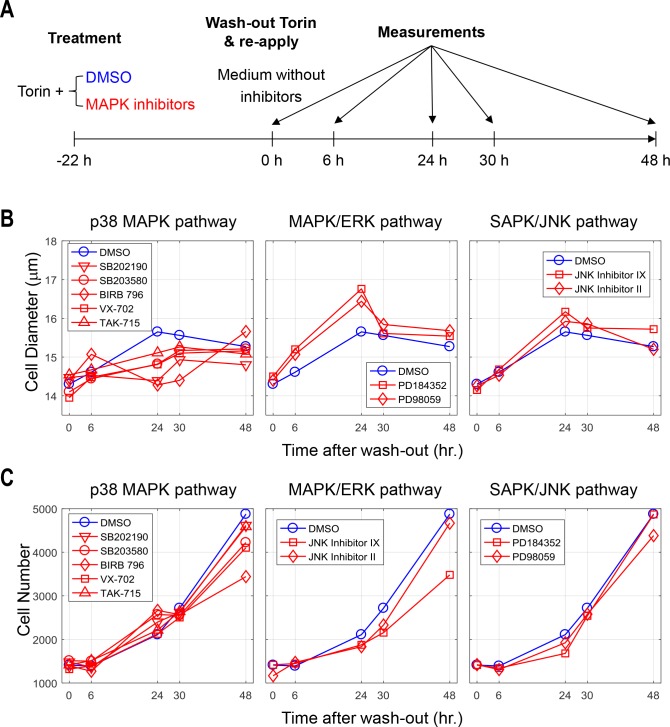
Recovery in cell size is delayed even after the p38 inhibitor was wash-out.(A) Workflow of the experiment. Similarly as indicated in Figure 6, Cells were co-treated with both Torin-2 (50 nM) with or without the indicated MAPK inhibitor for 22 hr. The cells were then released from both inhibitors and grown in regular medium. At 0, 6, 24, 30, and 48 hr post release from the inhibitors, the cells were measured for both cell size (B) and cell number (C) by Coulter counter. (B) Cells in ‘DMSO’ condition recovered in size within 24 hr and stays at this size. Cells with a history of p38 inhibition, but not Erk or JNK inhibition, displayed a delayed size-recovery dynamics. (C) Cell proliferation were followed after release from the inhibitors. The results shown in this figure are representative of two replicate experiments. The measurements and source code used to visualize the results shown in this figure is presented in Figure 6—source data 1.